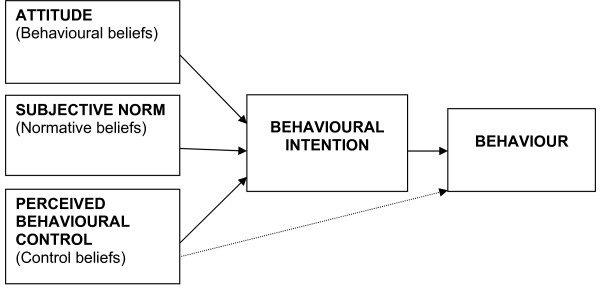
The Theory of Planned Behaviour (Ajzen, 1991). Note. The three variables also influence one another. Although this figure is presented in a simplified form, a more detailed diagram would include double-ended arrows joining these three variables.